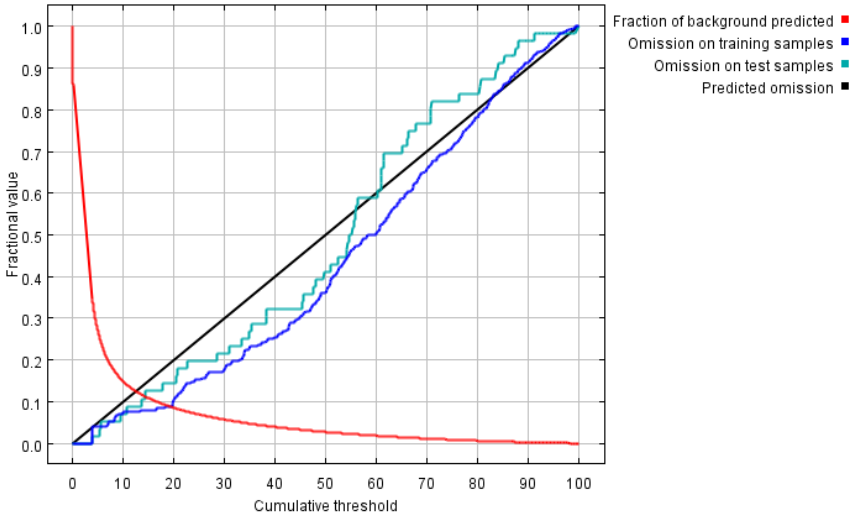
Figure 3. Average omission rate and predicted area (ORPA) from 2008 to 2020.